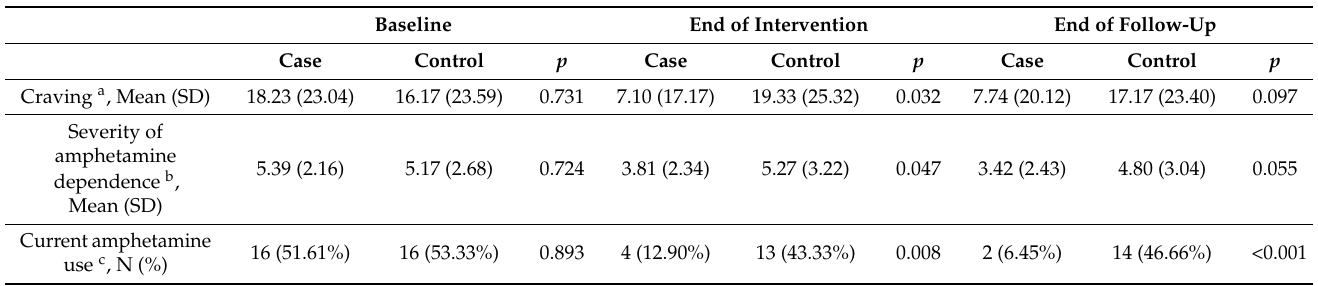
Table 2. Level of craving, amphetamine dependence severity and amphetamine use of the case and control groups at each assessment point.